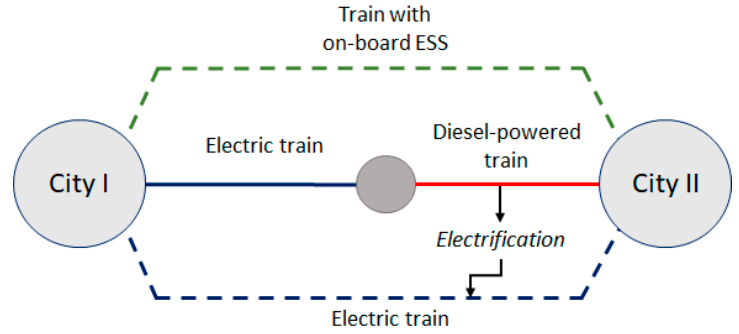
Figure 7. Railway connection between City I and City II and possible scenarios.